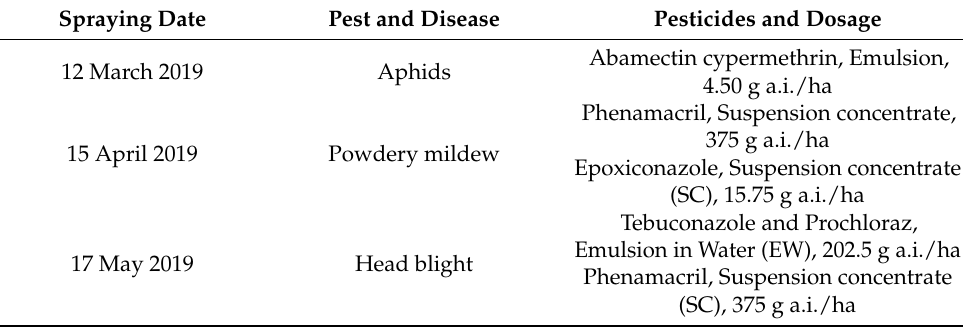
Table 4. The major wheat pests, diseases, and pesticide